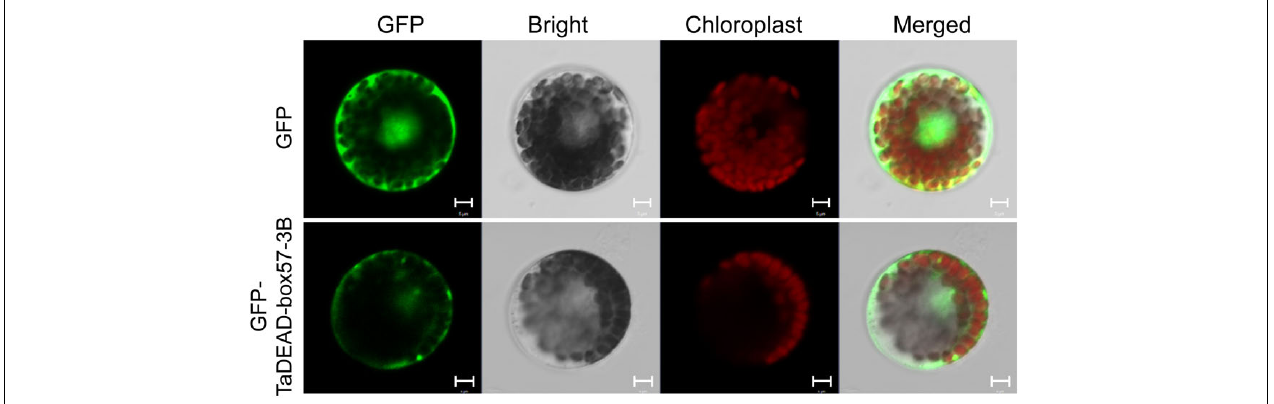
FIGURE 8 | Subcellular localization of TaDEAD-box57-3B. The p16318hGFP control vector and recombinant constructs were transiently expressed in wheat protoplasts. The green indicates GFP signals, and the red indicates chloroplast autofluorescence. Results were observed after transformation for 18 h with confocal microscopy. Scale bars = 5 µ